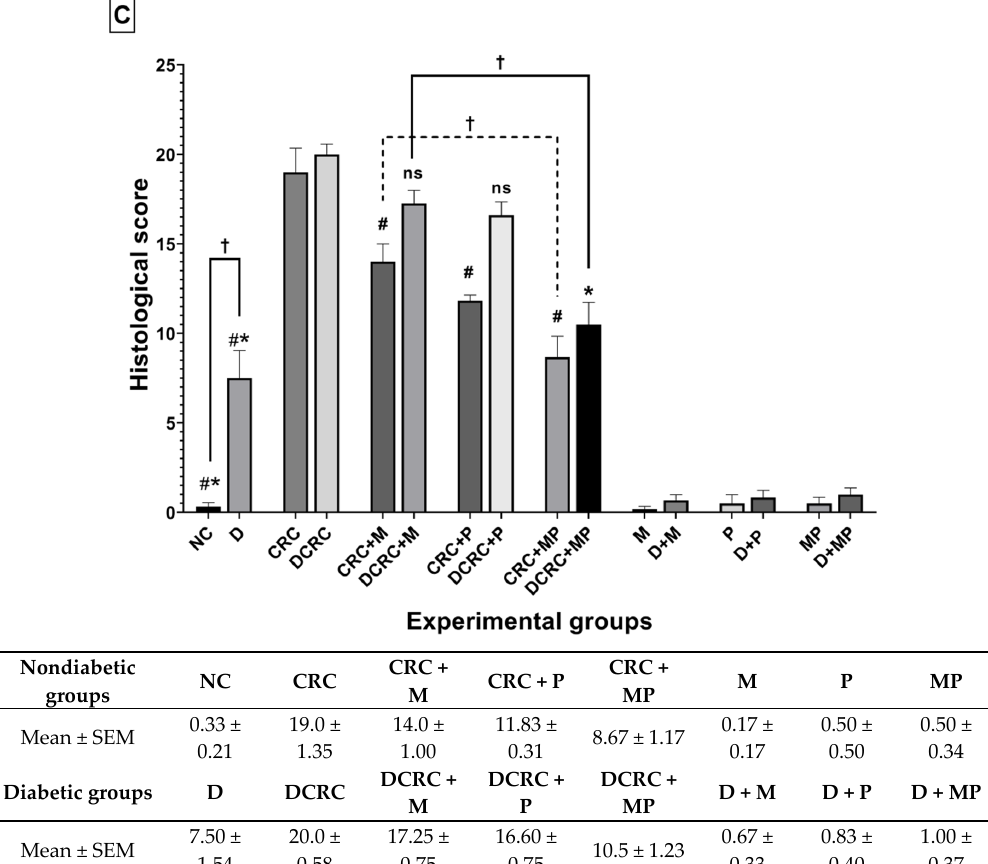
Figure 7. Effect of probiotics and metformin on colon histology. ( A,B ) Representative images of hematoxylin and eosin (H&E) ‐ stained colon sections illustrating the histological changes in the nondiabetic ( Panel A ) and diabetic ( Panel B ) groups. The worst alterations were encountered in the nontreated CRC (7A-e) and diabetic CRC (7B-m). Note the presence of large inflammatory cells infiltrates (circle), inflammatory cells invading the edematous submucosa (bracket), crypt abcess (black triangle) and cryptitis (black arrow), as well as crypt architecture disarray (star). Significant improvements in the combination treated mice in groups CRC + MP (7A ‐ h) and DCRC+MP (7B ‐ p) were noted. Original magnification: 4×; scale bars 100 μ m. Photos were adjusted for white balance using Adobe Photoshop ® ; ( C ) Histological alterations score. Data is expressed as average ± SEM ( n = 6). Nondiabetic groups were compared to their experimental CRC control (CRC), significance was expressed by # p < 0.05. On the other hand, diabetic groups were compared to their experimental diabetic CRC control (DCRC), significance was expressed by * p < 0.05. Moreover, when comparing only two groups, connecting lines were used to indicate the compared groups with † p < 0.05; (ns) stands for